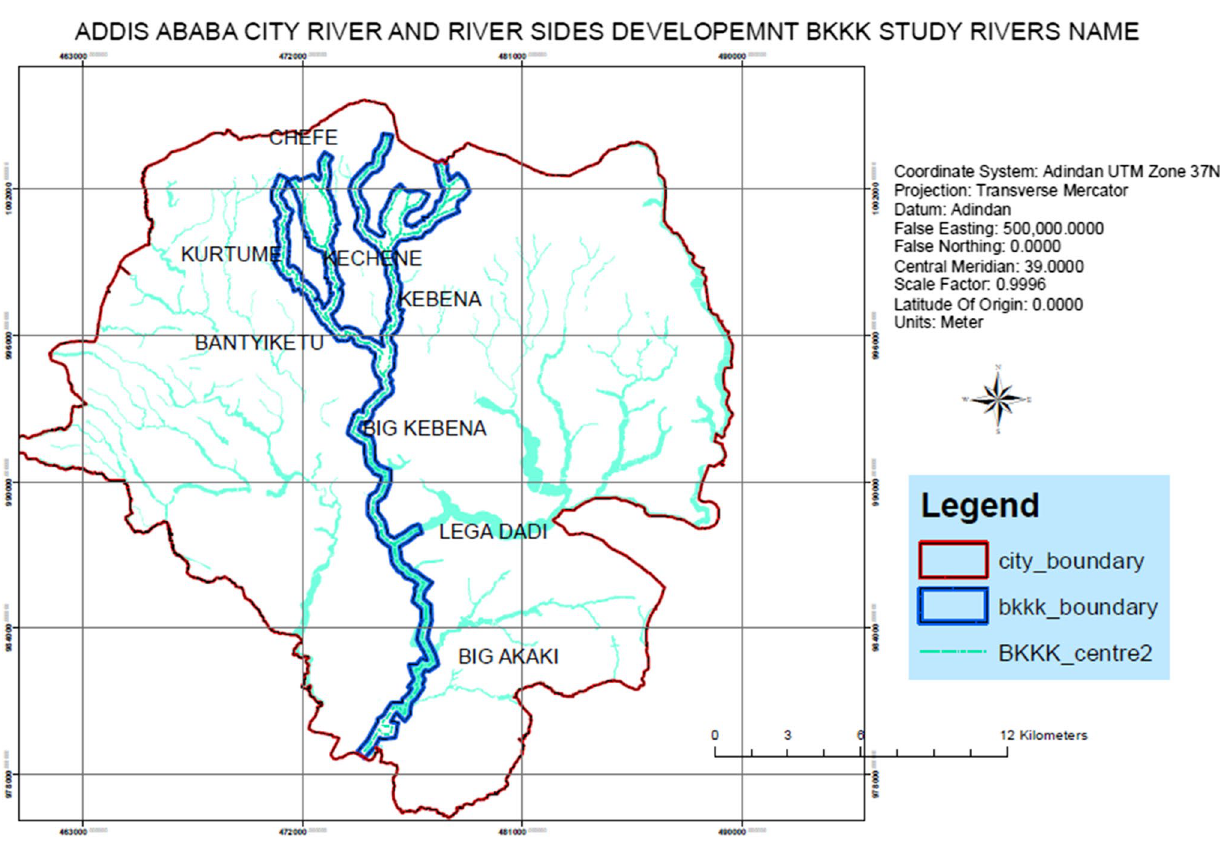
Fig. 5 Route of the rivers BKK + K. Source Addis Ababa Rivers, and Riversides Climate Change Adaptation Development Project